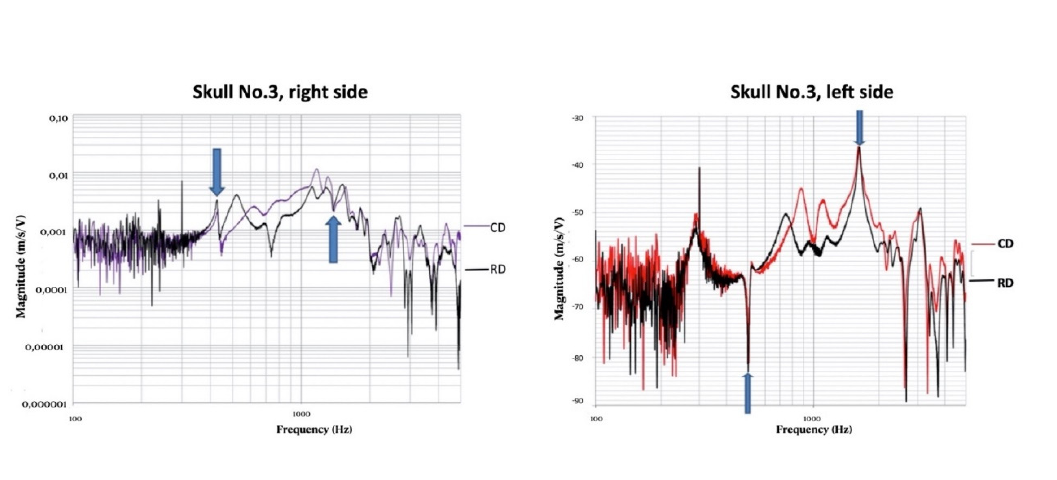
Table 2. Limit values of “ranges of differences”.